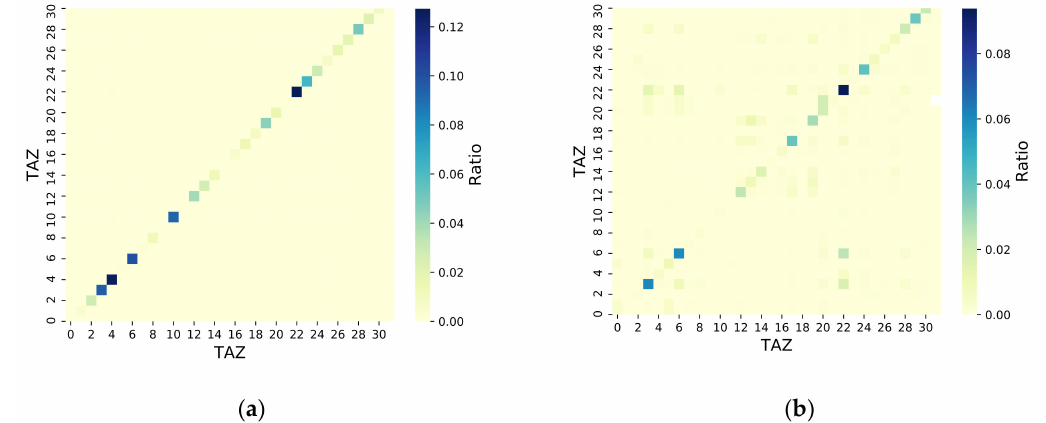
Figure 8. TAZ level origin–destination (OD) matrix from the LPR and CS data for one day. ( a ) CS OD matrix; ( b ) LPR OD matrix.